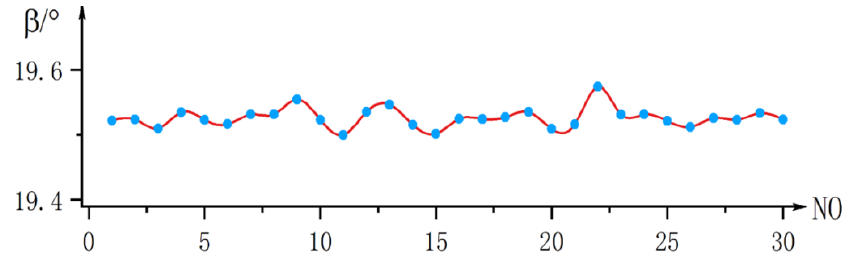
Figure 18. The calculation result of the helix angle.